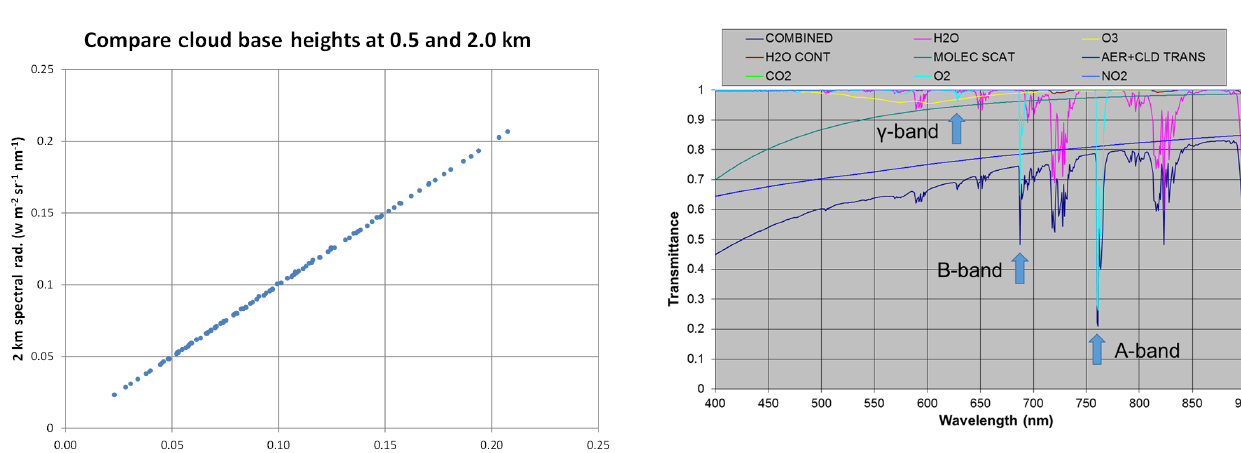
Figure 11. MODTRAN5 calculation of atmospheric transmittance for a ground-based zenith path to space. The oxygen A-Band is vir- tually free of absorption by any other species except for aerosol and cloud continua extinction. At 0.1cm − 1 spectral resolution, H 2 O (water vapor) has a minimum transmittance of 0.9972 across the